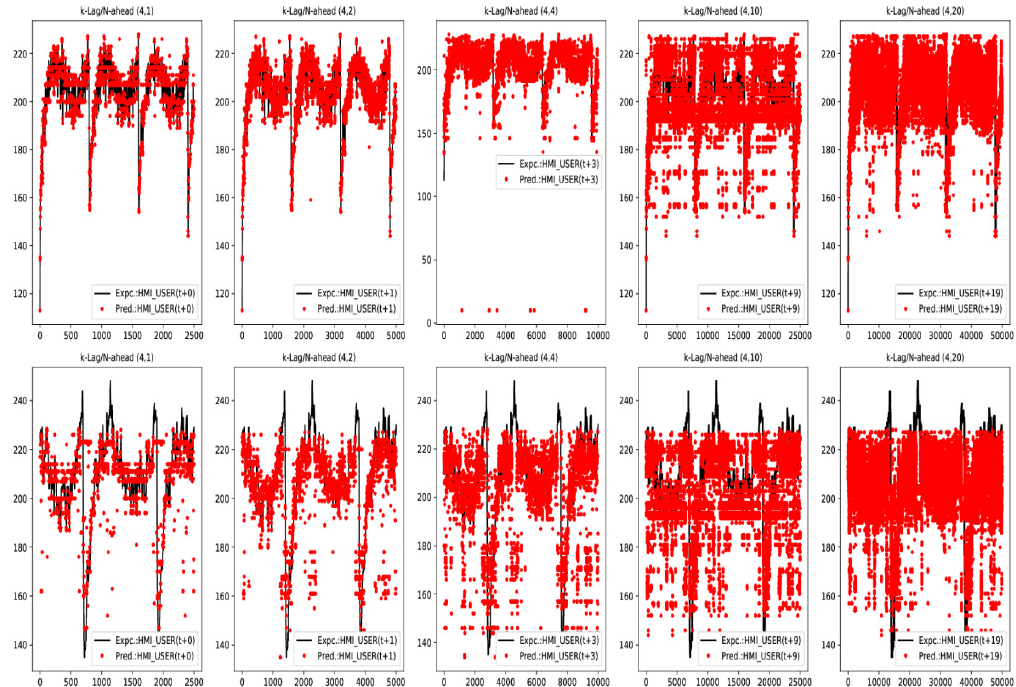
Figure 19. Trident Model—Expected(solid line) vs. Predicted(red dots) Operator response traces for Teacher Forcing test case from In-Sample (top row) & Out-of-Sample (bottom row) data sets test under K-Lag = [ 4 ] and N-Step = [ 1,2,4,10,20 ] runs (in left to right